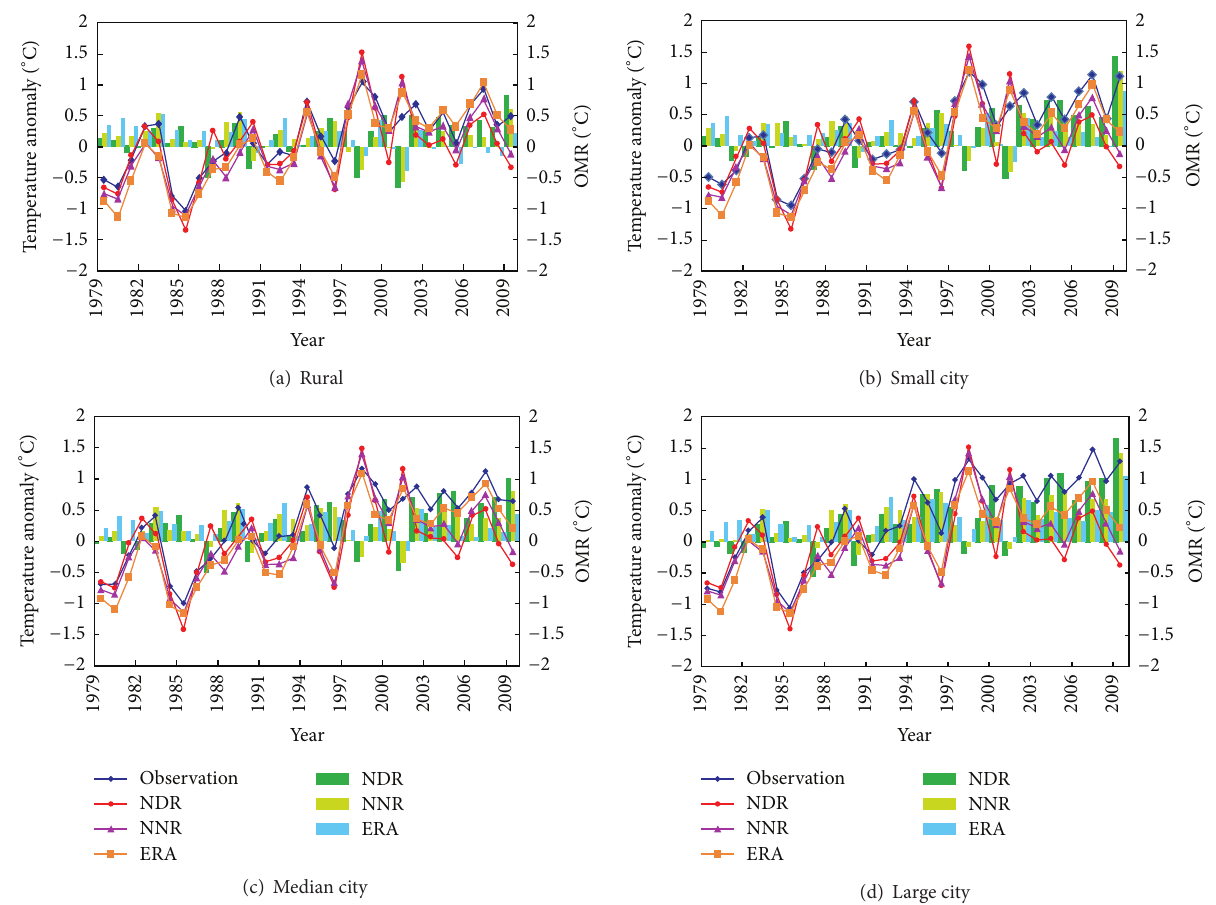
Figure 6: Observation and reanalysis time series of temperature anomalies (line graph) and OMR values (bar chart) for (a) rural, (b) small city, (c) medium city, and (d) large city groups from 1979 to